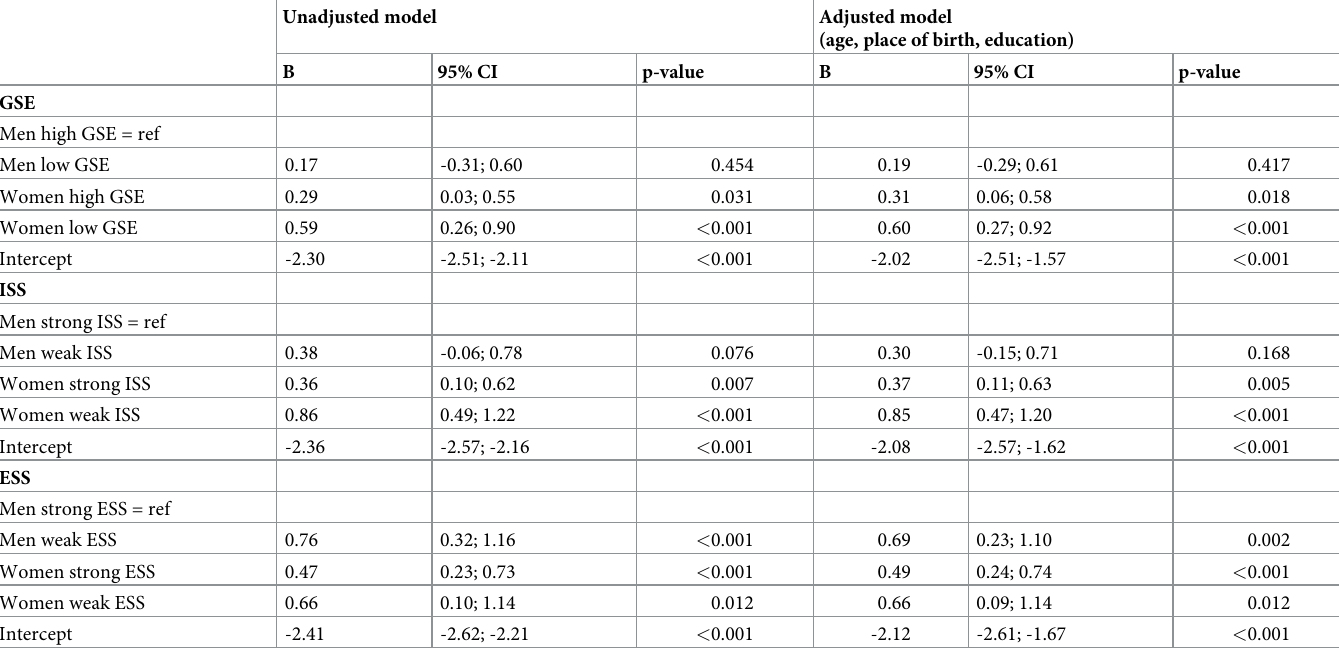
Table 2. The associations between general self-efficacy (GSE), instrumental social support (ISS) and emotional social support (ESS) at baseline and risk of frequent pain at follow-up. Unadjusted